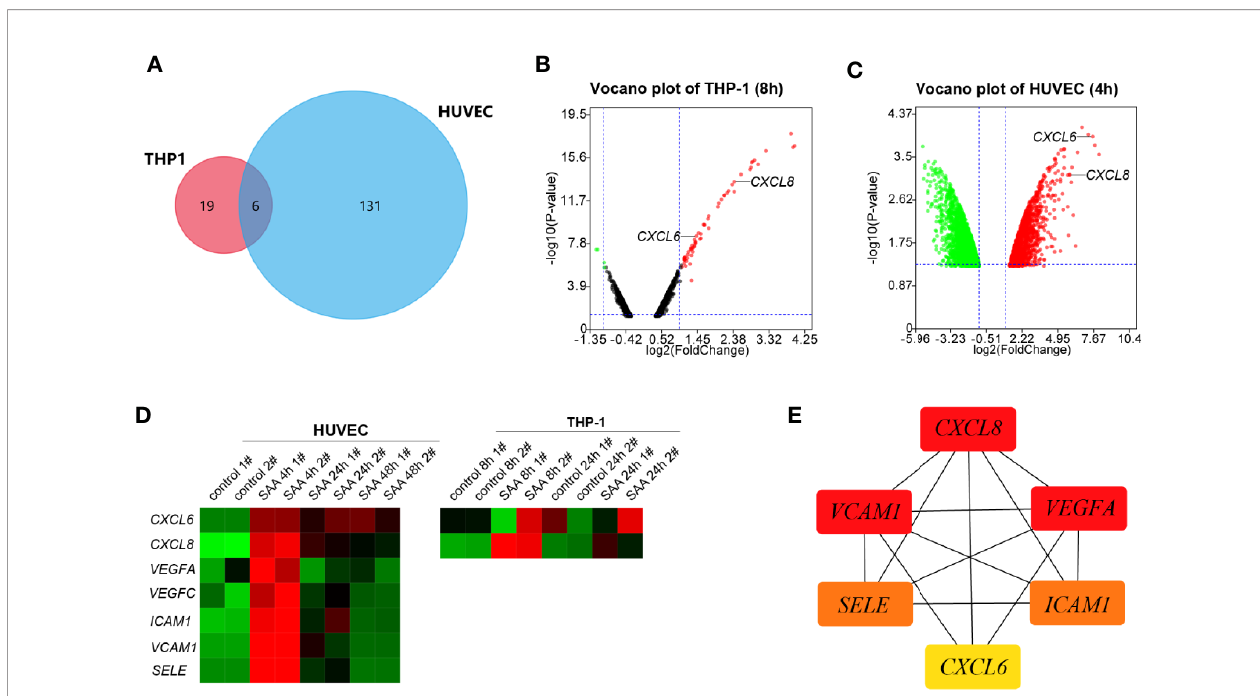
FIGURE 1 | (A) Venn plot for the six overlapped genes identi fi ed from GSE28785 and GSE6241. (B) Volcano plots of SAA treatment on global gene expression in THP-1 macrophages for 8 h from GSE28785. (C) Volcano plots of SAA treatment on global gene expression in HUVEC for 4 h from GSE6241. (D) Heatmap was drawn to describe levels of potential hub gene expressions. (E) The six genes were ranked by the CytoHubba plugin. The lines show the interactions between them. The red and yellow nodes represent the rank of hub genes from high to low according to the degree. The more forward ranking is represented by a redder